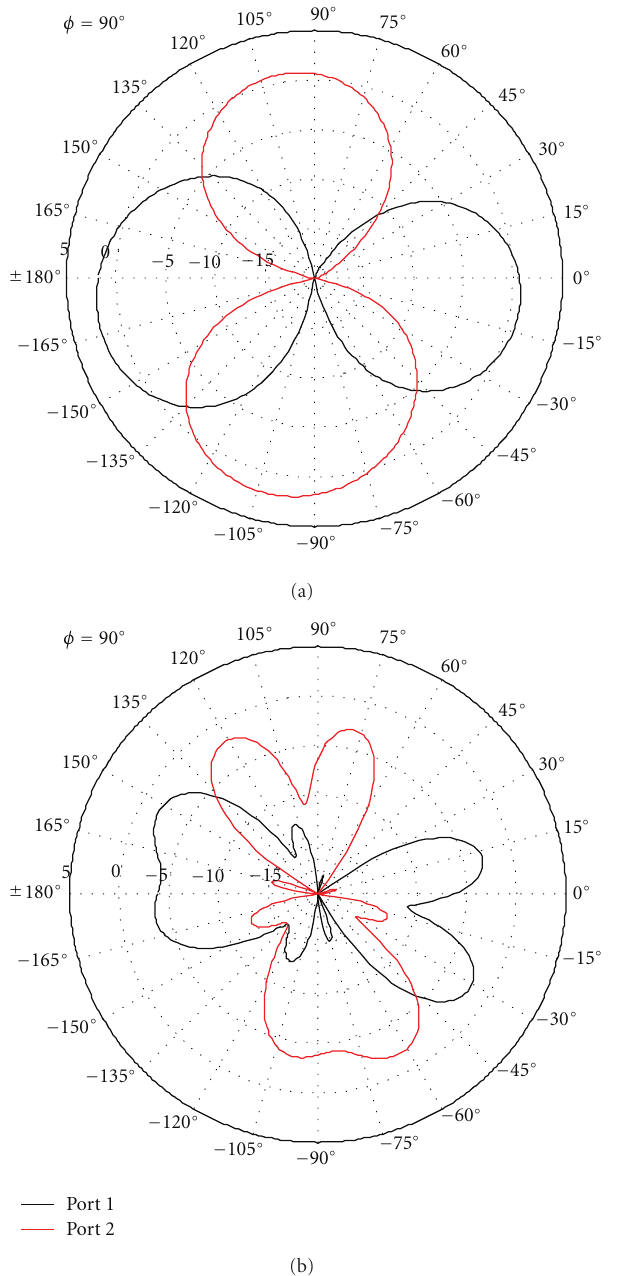
Figure 10: Simulated realized gain (dB) on the XY plane for the two bands: (a) at 778 MHz (b) at 2.6 GHz.